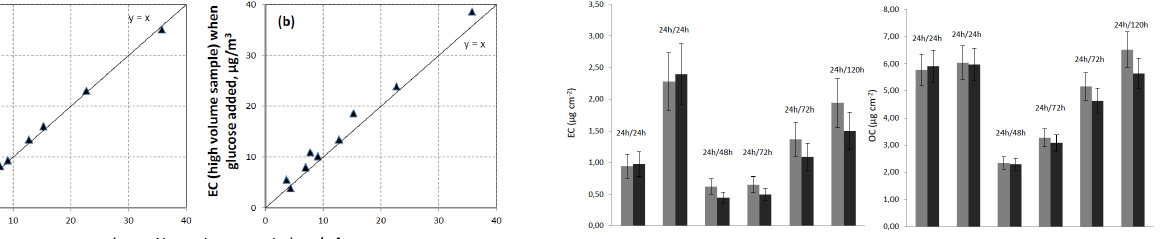
Figure 8. Comparison between EC measured on high-volume sam- Fig. 8. Comparison between EC measured on high-volume samples and EC calculated as the sum of low-volume 2 samples. a) EC only; b) EC plus glucose spiked on the filters. 3 ples and EC calculated as the sum of low-volume samples. (a) EC only; (b) EC plus glucose spiked on the filters.